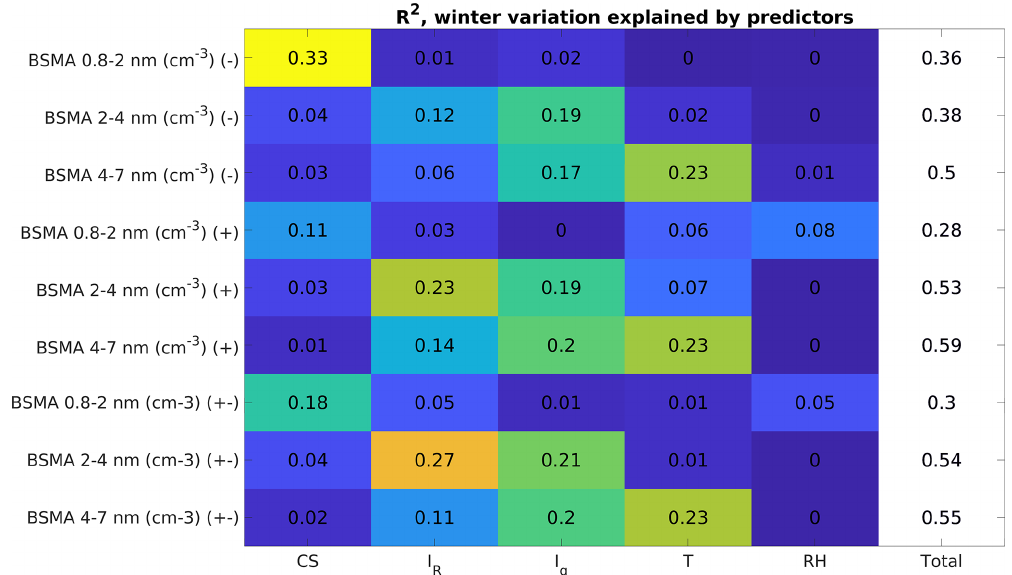
Figure A6. The amount of variation explained by our chosen explanatory variables for each size range and polarity. The data points selected are only between December and February and represent changes in wintertime concentrations. The symbol ( − ) denotes negative polarity, ( + ) a positive polarity, and ( ± ) the sum of both polarities. The bolded red values are statistically significant ( p < 0 . 05).